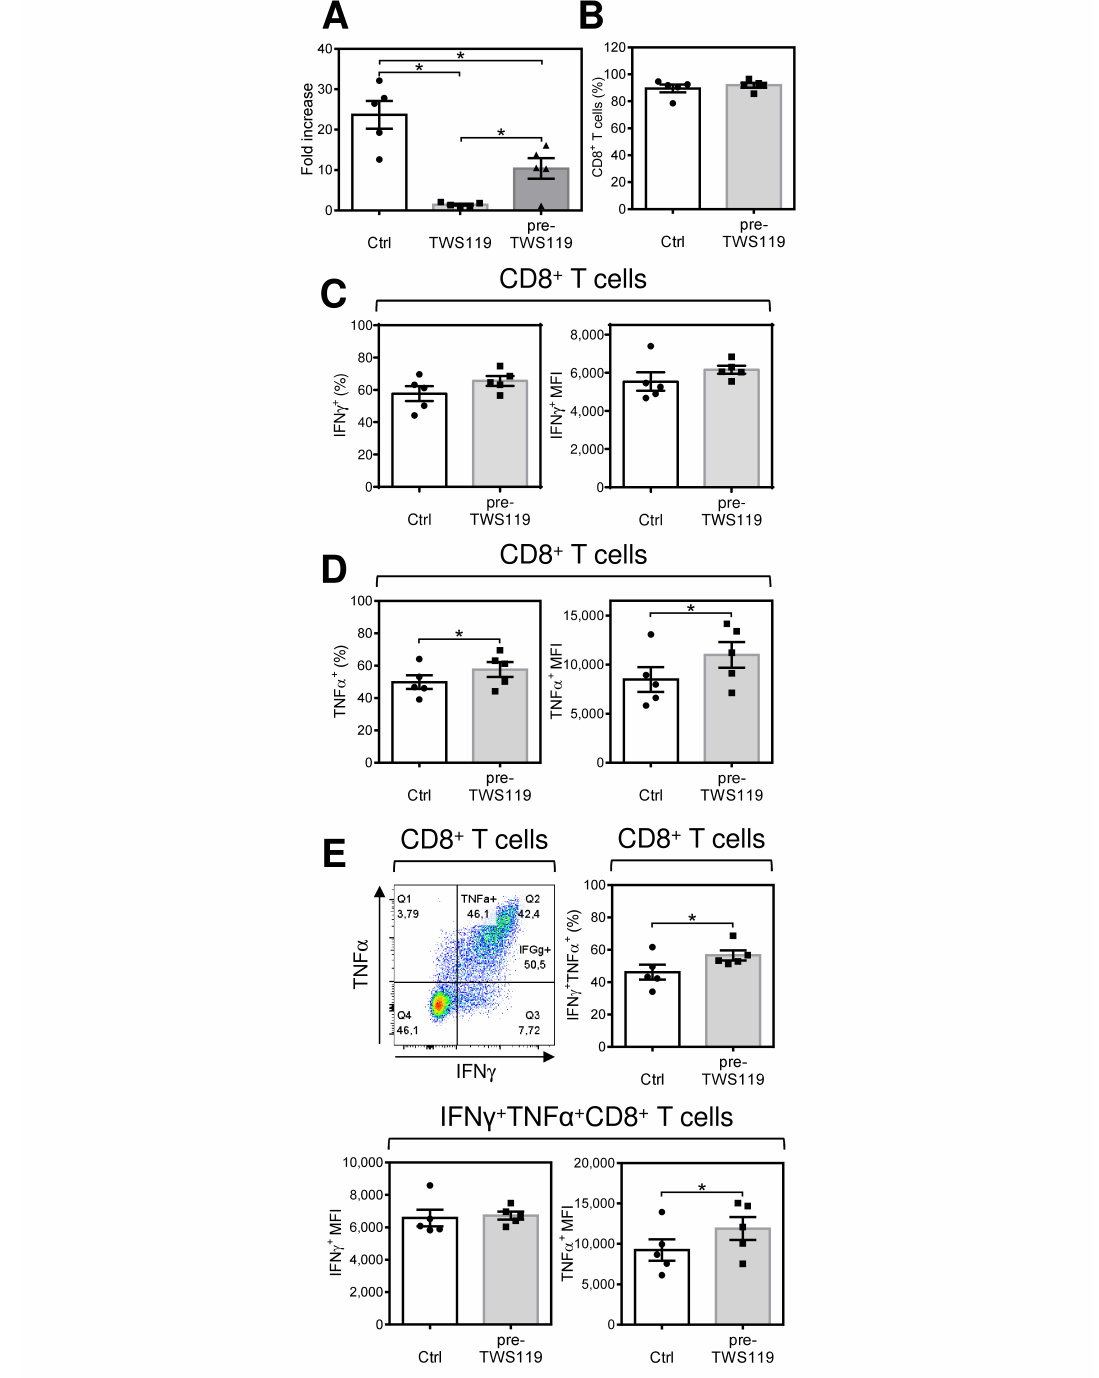
Figure 5. Acute conditioning of the expanded CD8 + T cells with the GSK-3 β inhibitor TWS119 prior to antigen rechallenge promotes re-expansion of CD8 + T cells with enhanced production of TNF α after antigen stimulation. The 14-day-expanded lymphocytes were reconstituted and cultured for 18–24 h with IL-2 (80 IU / mL). The cells were pelleted, resuspended in IL-2-containing medium (80 IU / mL) supplemented with TWS119 (7 µ M), and cultured for 18–24 h. The cells were pelleted, resuspended in fresh IL-2-containing medium (80 IU / mL), stimulated with UV-irradiated PC-3 cells as in Figure 1, and 7-day re-expanded and analyzed as in Figure 2. ( A ) The cell number fold increase of the 7-day re-expanded lymphocytes with TWS119 during pretreatment and expansion (TWS119), duringpretreatment(pre-TWS119), orwithoutTWS119(Ctrl).( B )TheproportionoftheCD8 + population of T cells in the re-expanded culture. ( C ) The proportion of the IFN γ + population (left panel) and its intensity of staining (MFI) (right panel) of CD8 + T cells. ( D ) The proportion of the TNF α + population (left panel) and its intensity of staining (MFI) (right panel) of CD8 + T cells. ( E ) The gating strategy